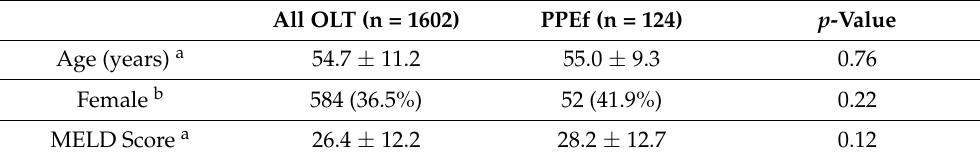
Abbreviations: MELD, Model for End-Stage Liver Disease; OLT, orthotopic liver transplant; PPEf, persistent pleural effusion. a = mean ± SD. b = n (%).